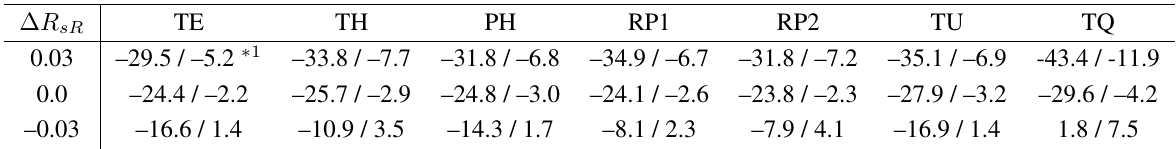
Table 5. Expected relative difference (%) in NDVI values from the results with a general soil line at LAI = 0.25 and